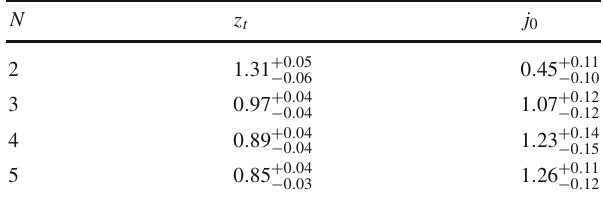
Table 3 Best-fit values of z t and j 0 (within 1 σ errors) for Model 1 by considering different values of N . Here, z t is the transition redshift and j 0 is the present value of j . For this analysis we have considered SNIa + BAO/CMB